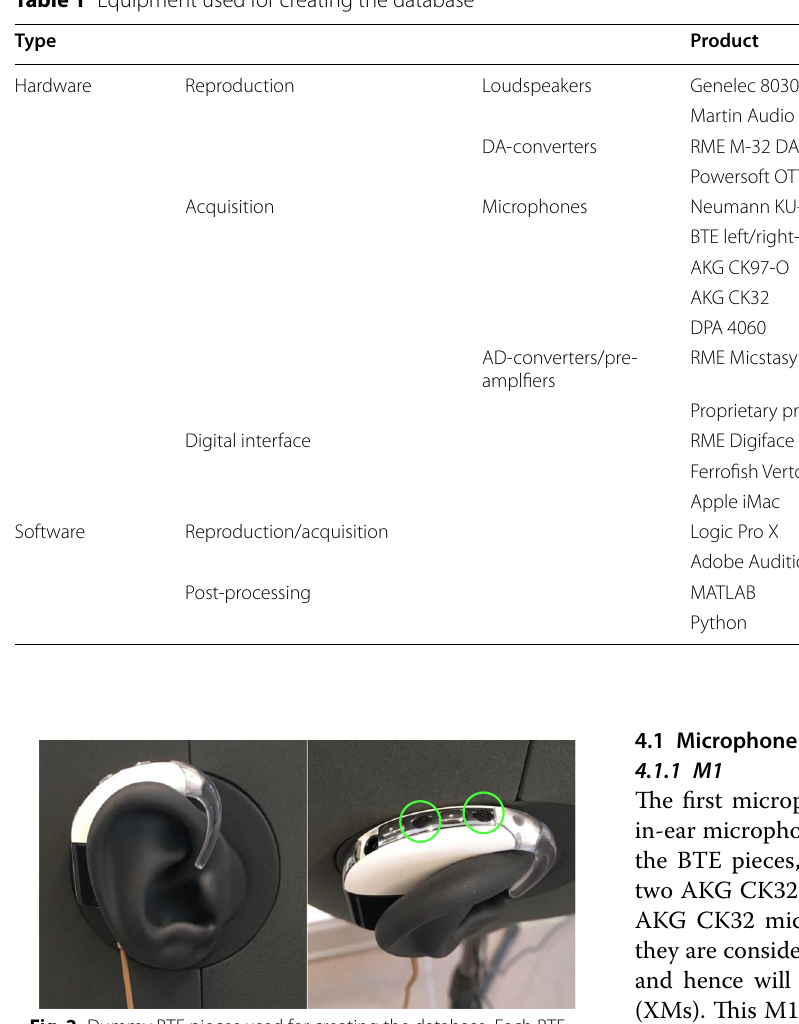
4 Note that XM1 is taped on a stand of 18 mm diameter (holding the DH), which may impact the effective directivity pattern of the microphone at high